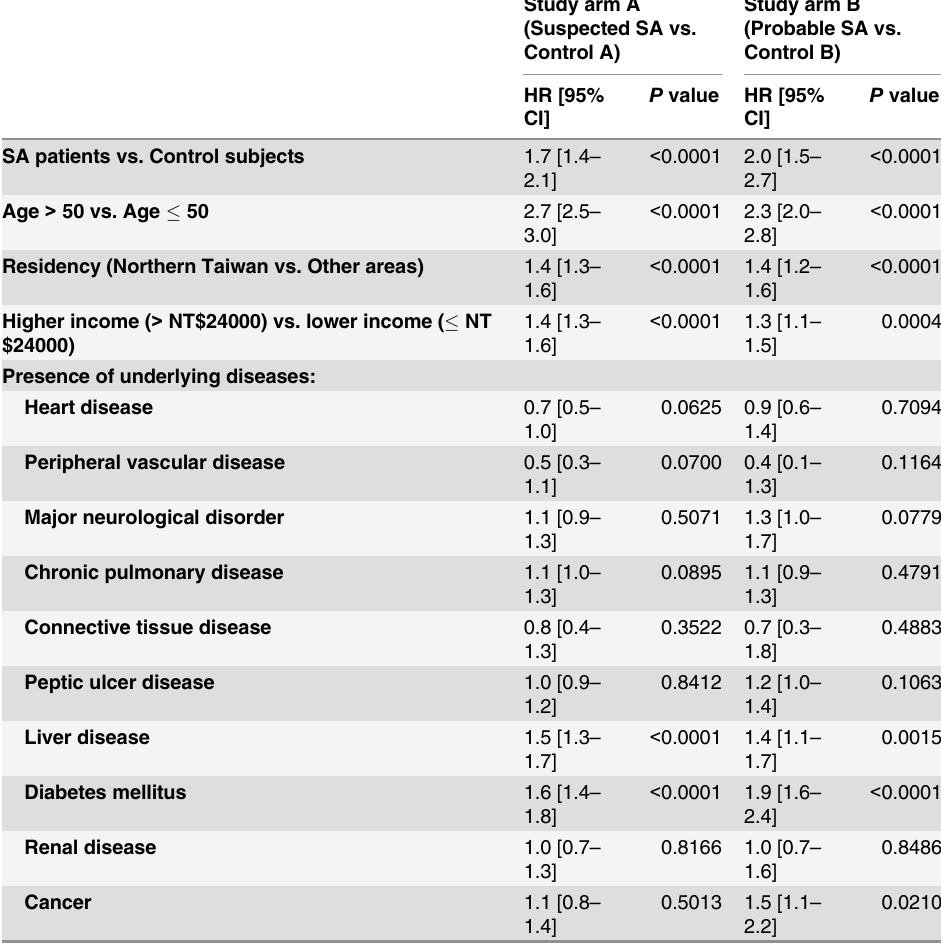
Table 3. Multivariable Cox regression analysis of the factors contributing to erectile dysfunction – maximal models.